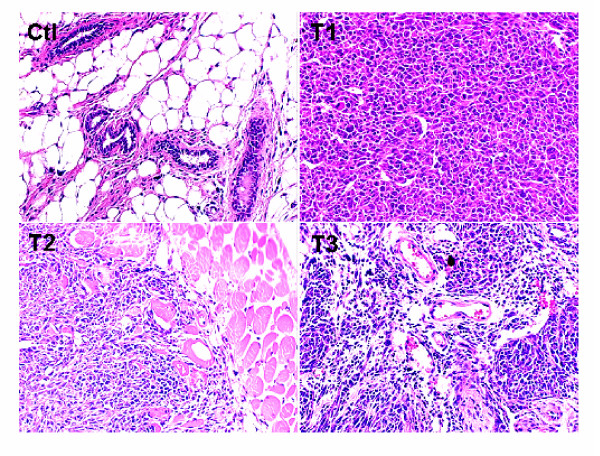
Neoplastic transformation and invasion of isografts of Comma/PDK1 cells. H&E stained paraffin-embedded tissue obtained from isografts of cells transduced with either empty virus (Ctl) or PDK1 (T1, T2, T3) 8 weeks after transplantation. Mammary isografts of control cells have normal lobuloalveolar ductal morphology with surrounding adipose tissue. Comma/PDK1 isografts produced poorly differentiated adenocarcinomas with solid cords of cells with little gland formation (T1), invasion of underlying skeletal muscle (T2) and vascularity (T3). Magnification: 100×.